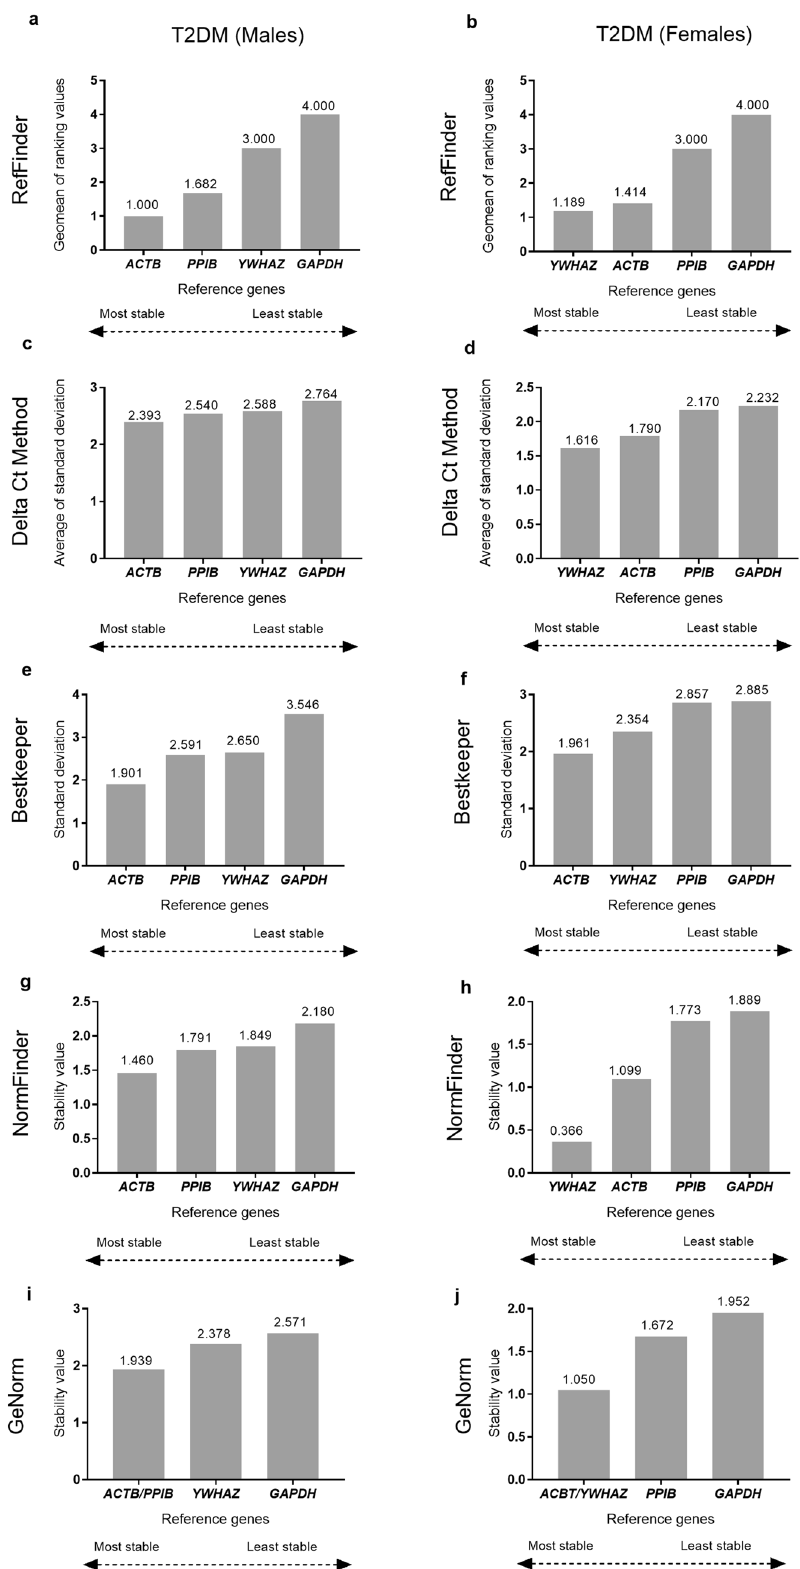
Figure 3. Gender-based expression stability analysis and ranking of the 4 reference genes provided by RefFinder tool and different algorithms considered by RefFinder for the T2DM group (n = 39) and separately for T2DM Males (n = 20) and T2DM Females (n = 19). Comprehensive ranking of the reference genes provided by RefFinder for ( a ) Males, ( b ) Females; Gene expression stability plots and subsequent ranking of the reference genes by Delta Ct method 41 for ( c ) Males, ( d ) Females; BestKeeper 40 for ( e ) Males, ( f ) Females; NormFinder 39 for ( g ) Males, ( h ) Females; and GeNorm 37,38 , based on average stability value (M value) for ( i ) Males, ( j ) Females; The most stable genes are on the left side and the least stable genes are arranged on the right side. The stability values, for each gene are indicated as data labels on the